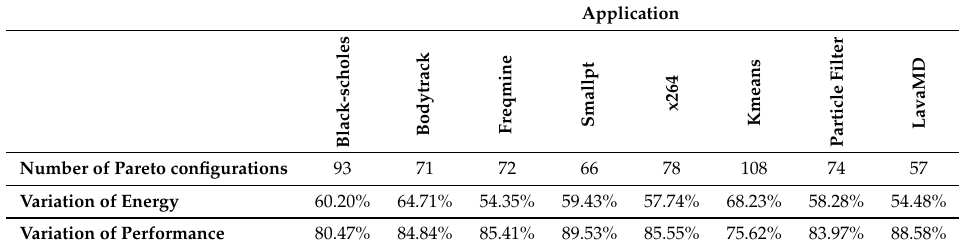
Table 4. Pareto Frontier energy and performance variations concerning the measured values and the total number of Pareto